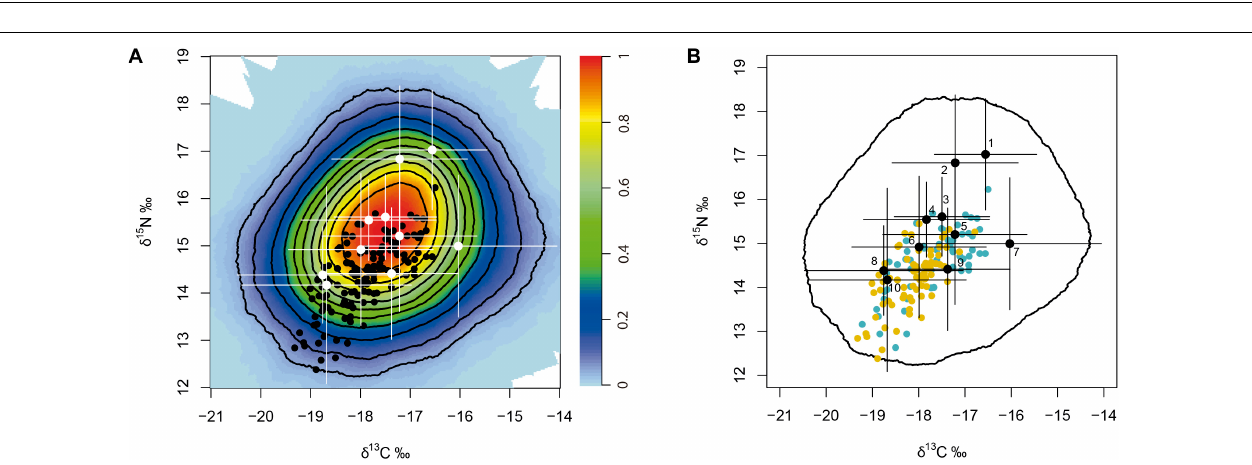
FIGURE 1 | Stable isotope ellipses in RBC samples corrected for small samples size (SEA c ) for 2010, 2011, 2017, 2018, and 2019. Isotopic niche breath [as represented by Bayesian standard ellipses areas (SEA b )] are also provided in the last plot for each year and sex.